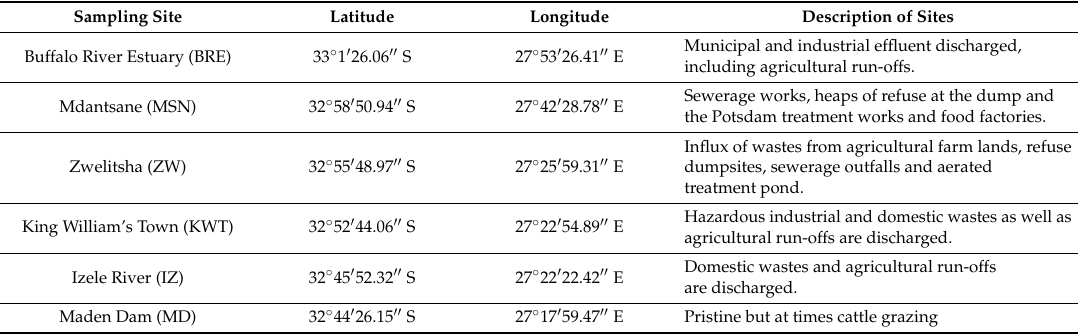
Table 1. Co ‐ ordinates of the sampling points. Table 1. Co-ordinates of the sampling